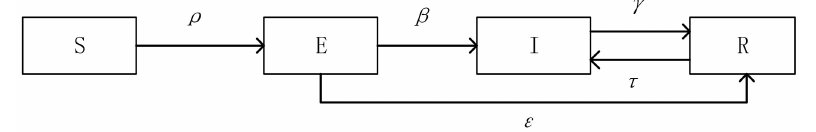
Figure 1. Node state transition